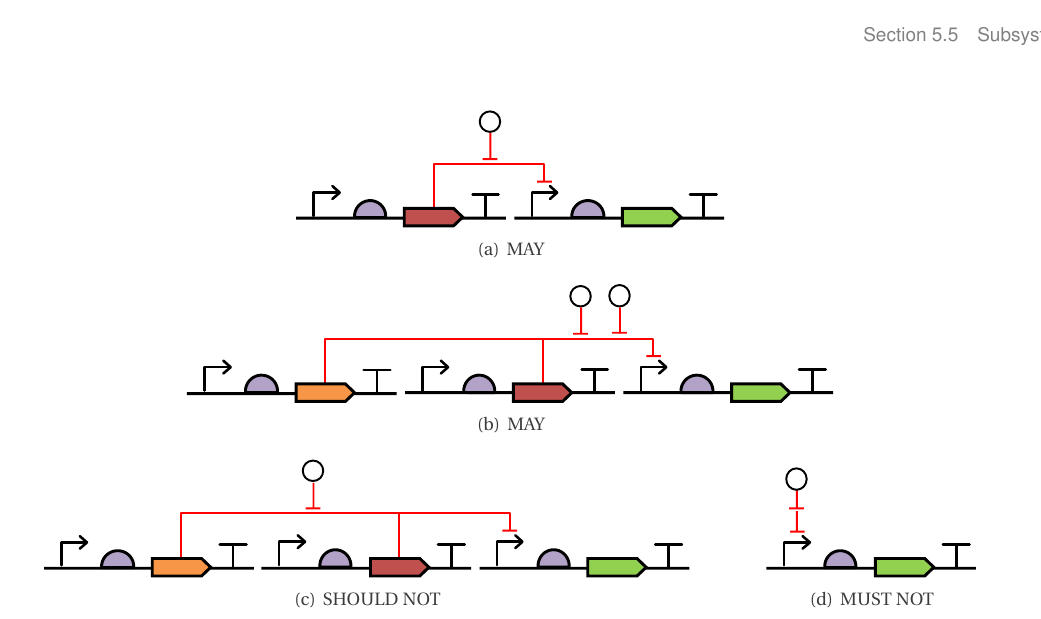
Figure 22: Examples of allowed and forbidden use of interactions with interactions: (a) aTc inhibiting repression by TetR. (b) Multiple inhibitions of an interaction with two tails. (c) Interactions SHOULD NOT connect to only one head of a multi-head or tail of a multi-tail interaction. (d) interactions MUST NOT connect to the head or tail of another interaction.